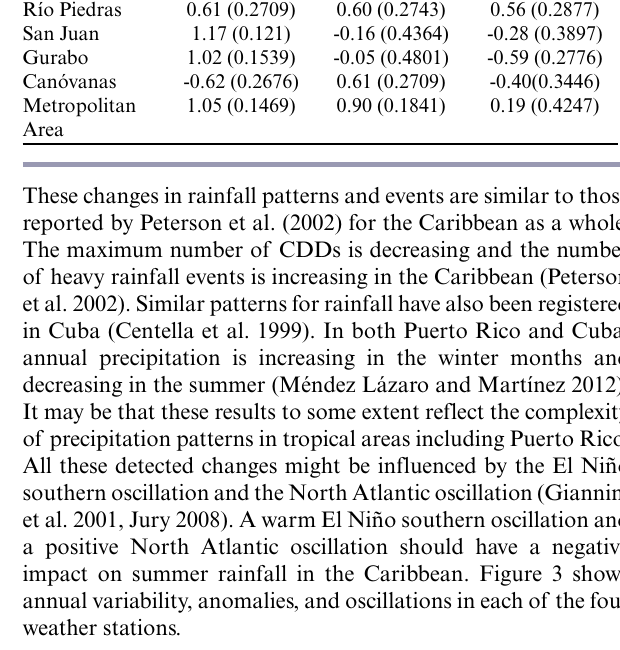
Table 5 . Mann-Kendall trend analysis for dry days. JJA = June- July-August; DJF = December-January-February.